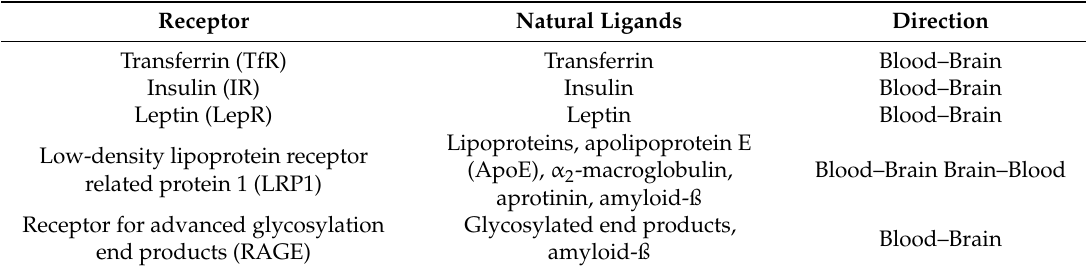
Table 3. Receptors at the brain endothelium initiating receptor-mediated